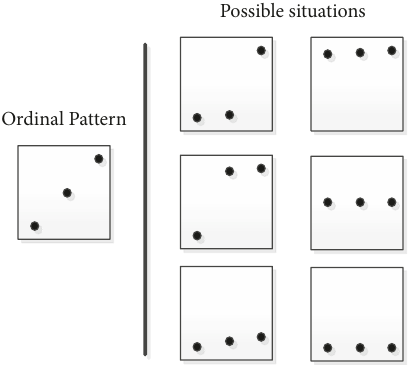
Figure 1: An example of some m -dimensional subvectors that are symbolized to the same ordinal pattern ( 𝑚 = 3 is used in this